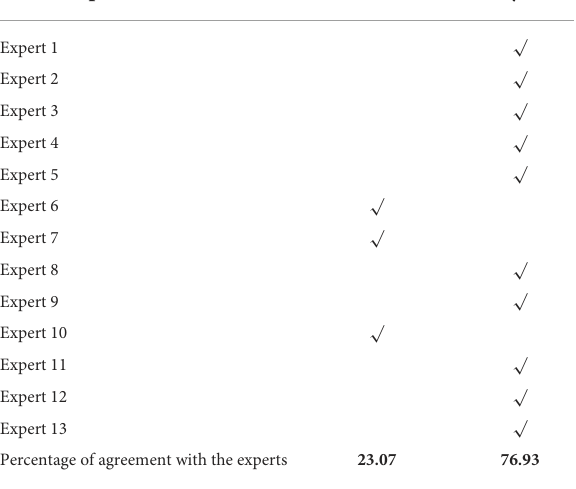
TABLE 11 Comparison between traditional and Fuzzy FMEA-RPN with the CMEC experts’ agreement. CMEC experts